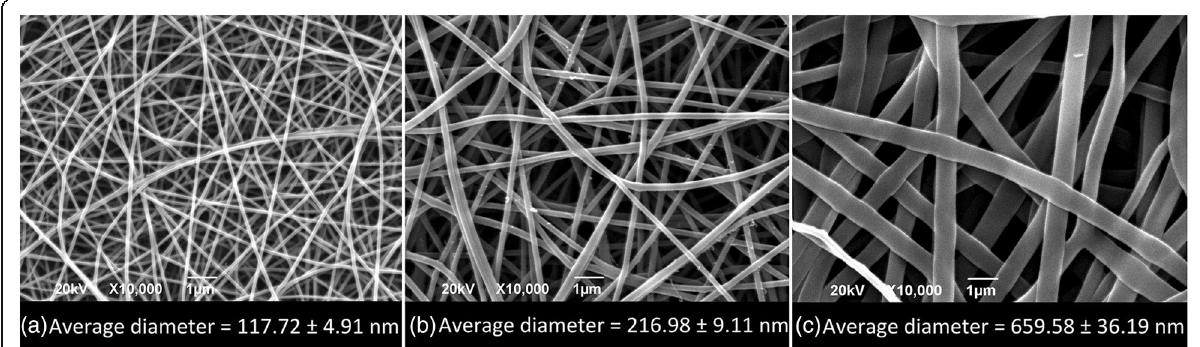
Fig. 3 SEM images of PA 6/66 electrospun nanofibers at different concentrations. a 12% wt., b 17% wt., and c 22% wt